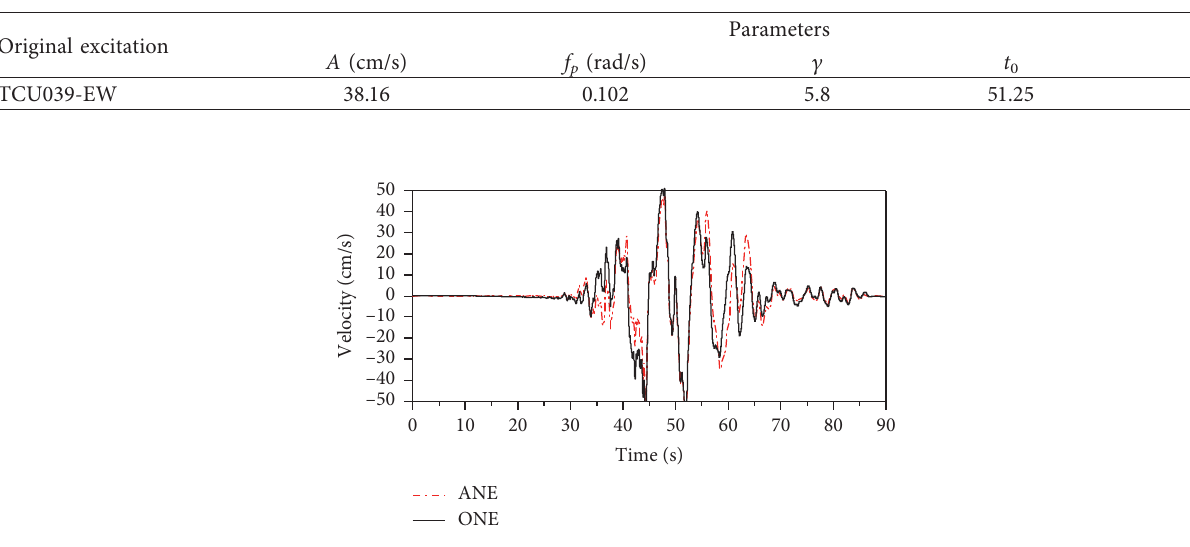
Table 6: Model parameters of